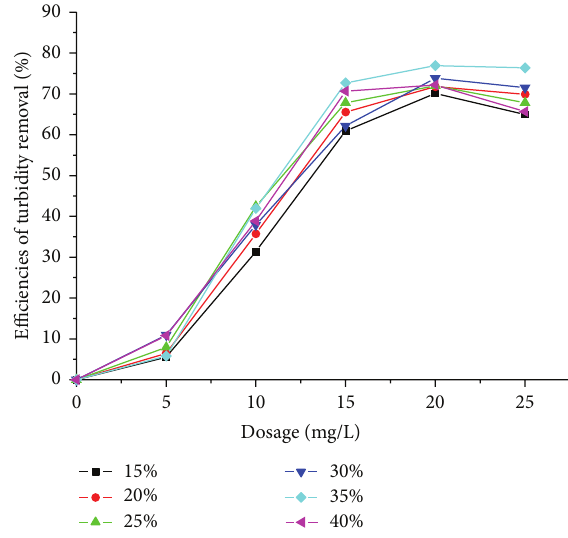
Figure 7: Effects of concentration of initiators on COD removal for sewage.